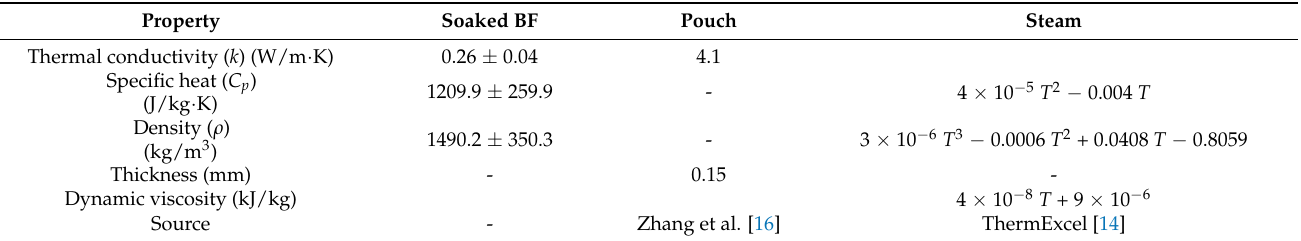
Table 1. Thermal properties of soaked BF and the pouch.